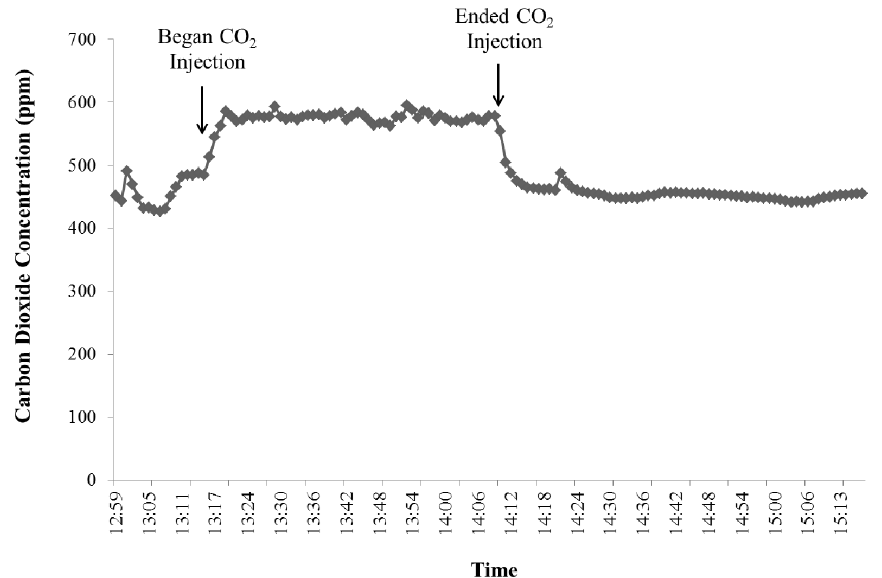
Figure 8. Carbon dioxide concentration (ppm) over time during recovery rate test for head hood